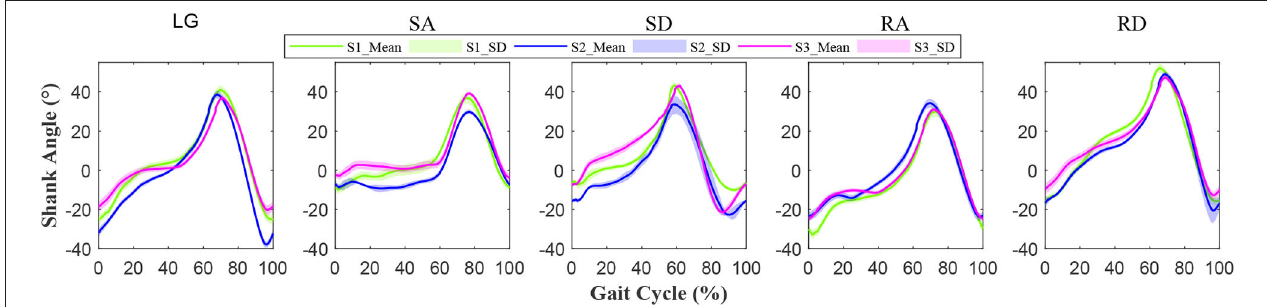
FIGURE 5 | Normalized angle signals of the prosthetic shank. The horizontal axis represents the gait cycle. One gait cycle is from heel strike to toe off and ends at the next heel strike of the prosthesis. The vertical axis denotes the shank angle of prosthesis relative to the vertical direction. The solid line shows the mean and the shaded area represents the standard deviation (SD) of the signal. The different colors represent different subjects (S1, S2, and S3), as shown in the